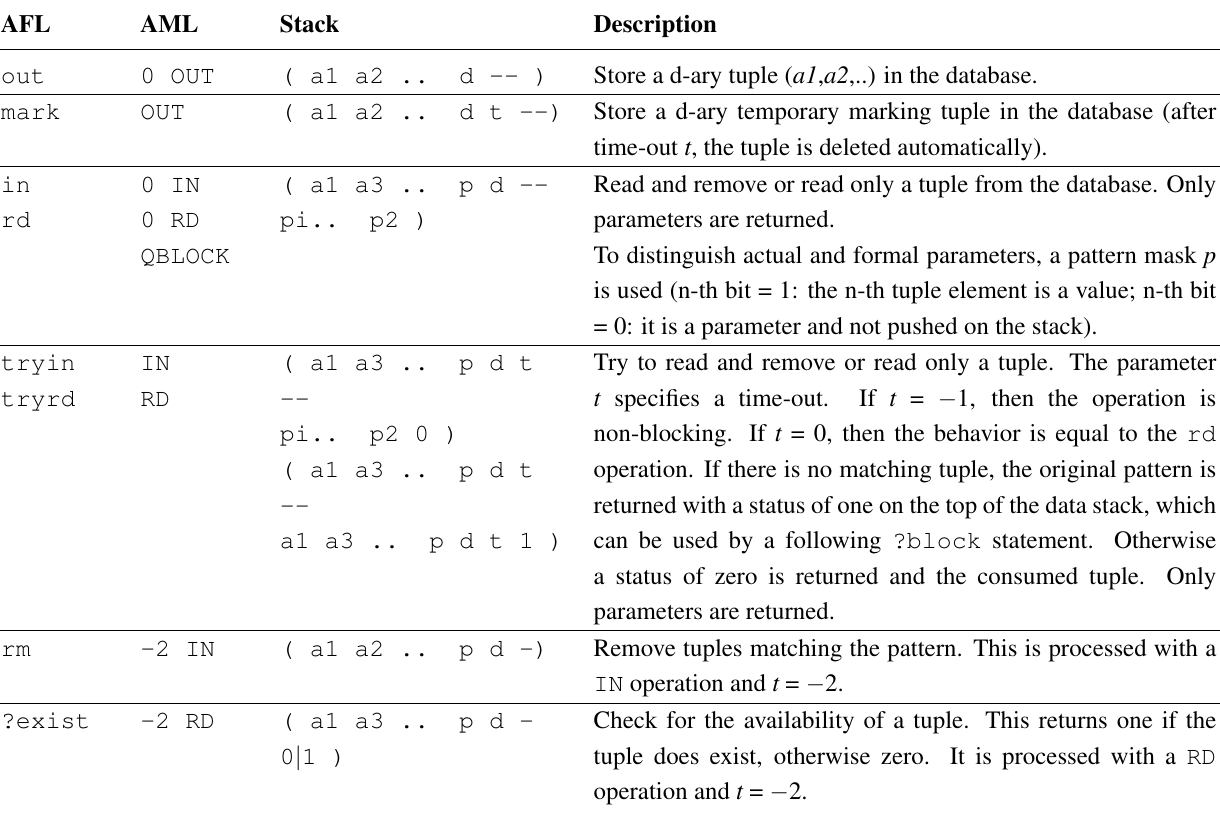
Table 5. AFL/AML tuple data space access